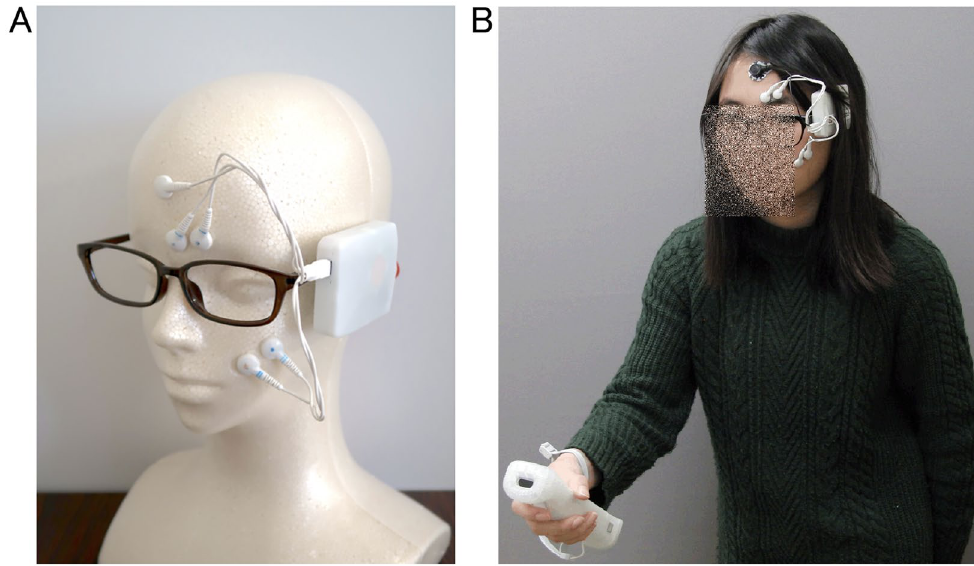
Figure 1. Illustrations of the wearable device ( A ) and participants using the wearable device in Experiment 2 ( B